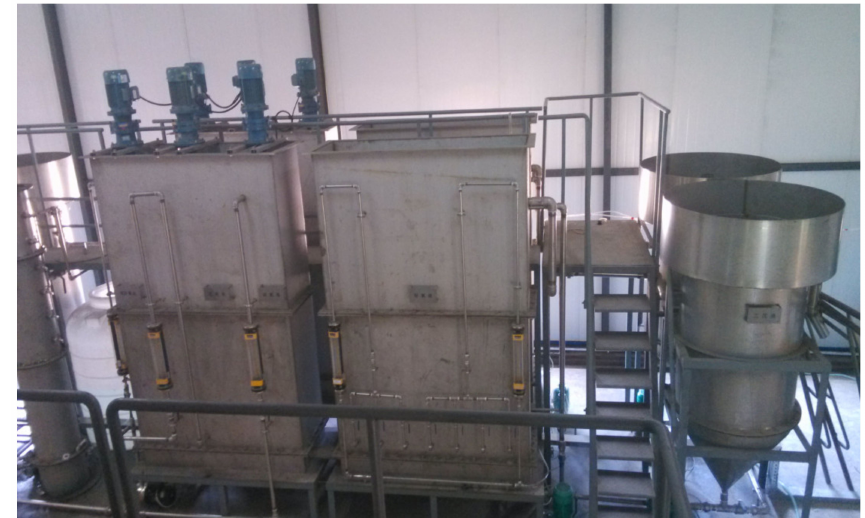
Figure 1. A physical photograph of the improved anaerobic–anoxic–aerobic-ozoneA 2 / O reactor. Mechanical agitation was installed at the top of the pre-anoxic, anaerobic and anoxic zones. The bottom of the aerobic tank was provided with a perforated tube for aeration. The detailed operating parameters of the improved A 2 / O reactor are shown in Table 3. The inoculated sludge of the reactor was taken from the sludge return channel of the sewage treatment plant in